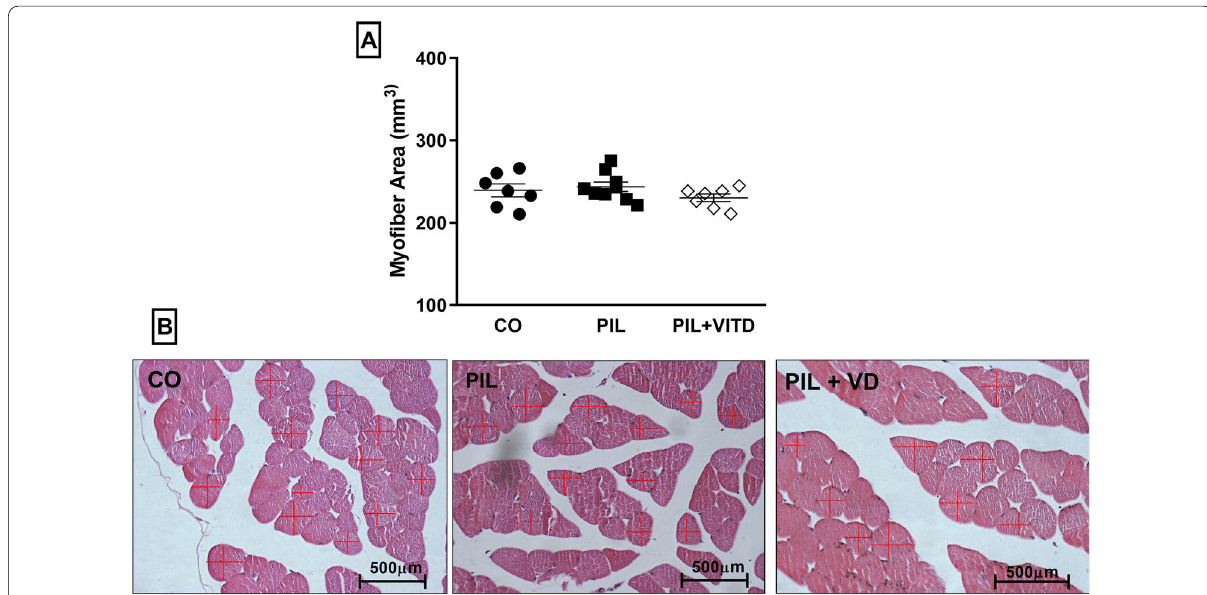
Fig. 3 Myofiber cross-sectional area (CSA) of tibialis anterior muscle a Measures of CSA in mice from CO, PIL and PIL hematoxylin and eosin (HE) staining of tibialis anterior sections from CO, PIL and PIL represented by mean SD. * p < ±